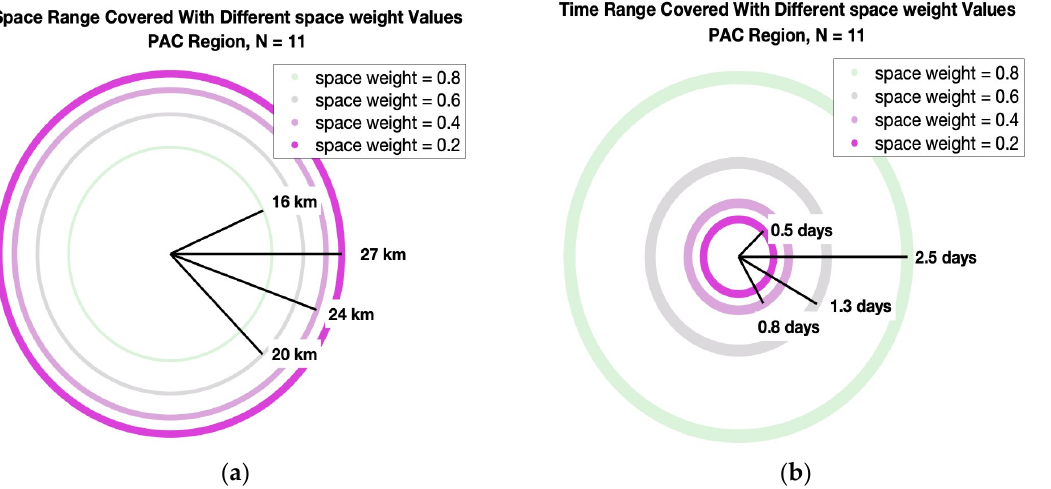
Figure 11. The mean space ( a ) and time ( b ) windows encompassed by the NCLO method in the PAC region using the Aquarius satellite and four different values of space_weight (0.90, 0.60, 0.40, 0.20) and an N value of 11. The size of the circle is dependent on the average distance between each Argo float in the PAC region and the furthest Aquarius observation in time or space that was included in its NCLO averaging. The thickness of the circle lines is indicative of the standard deviation.